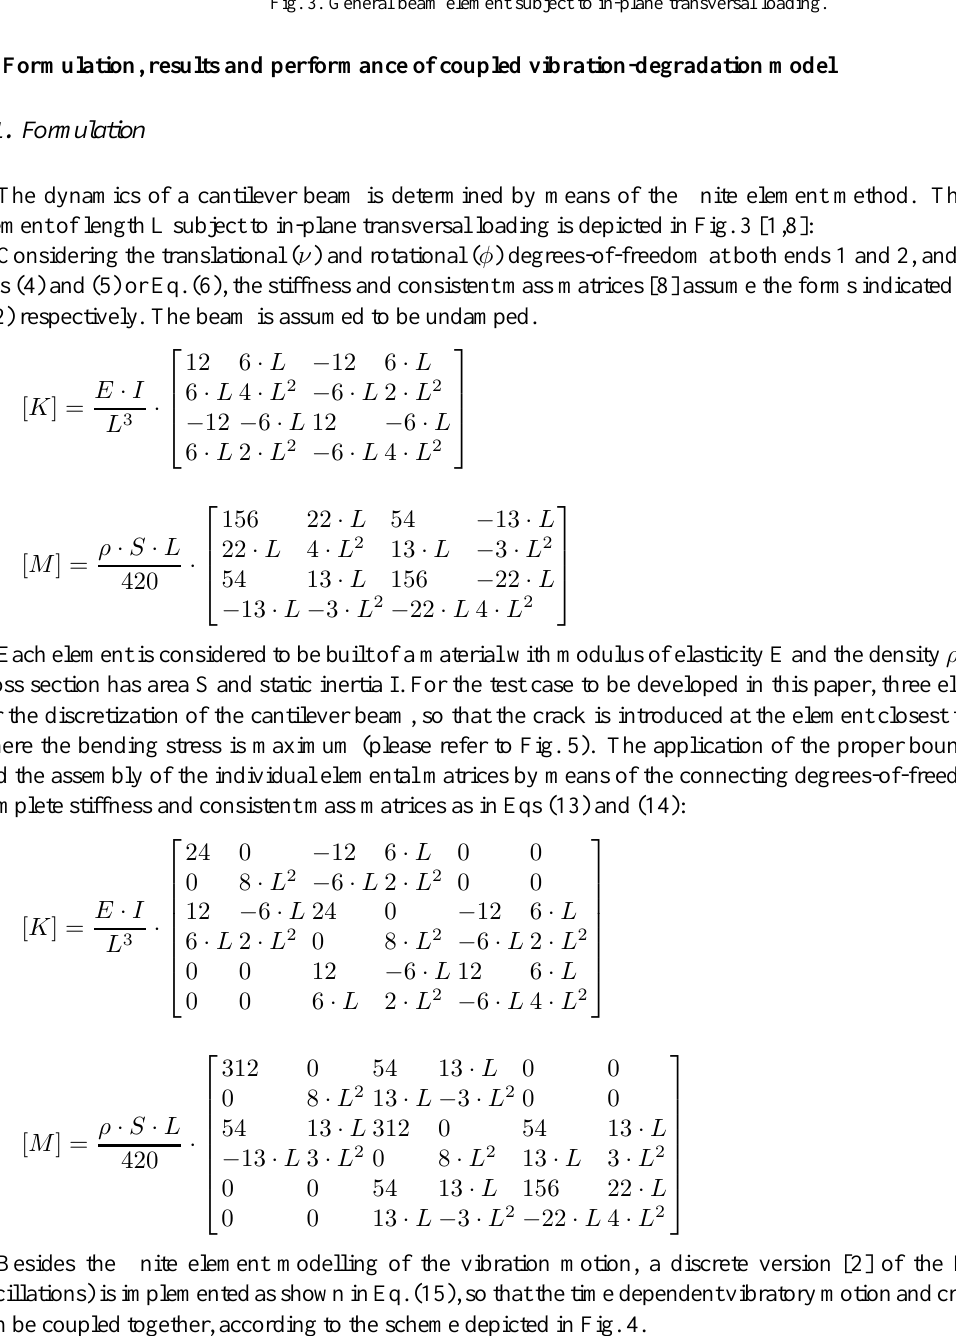
Fig. 3. General beam element subject to in-plane transversal